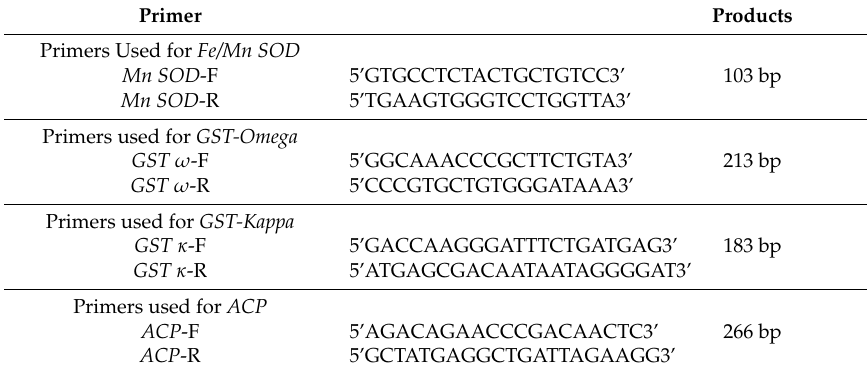
Table 5. All primers used in our validation